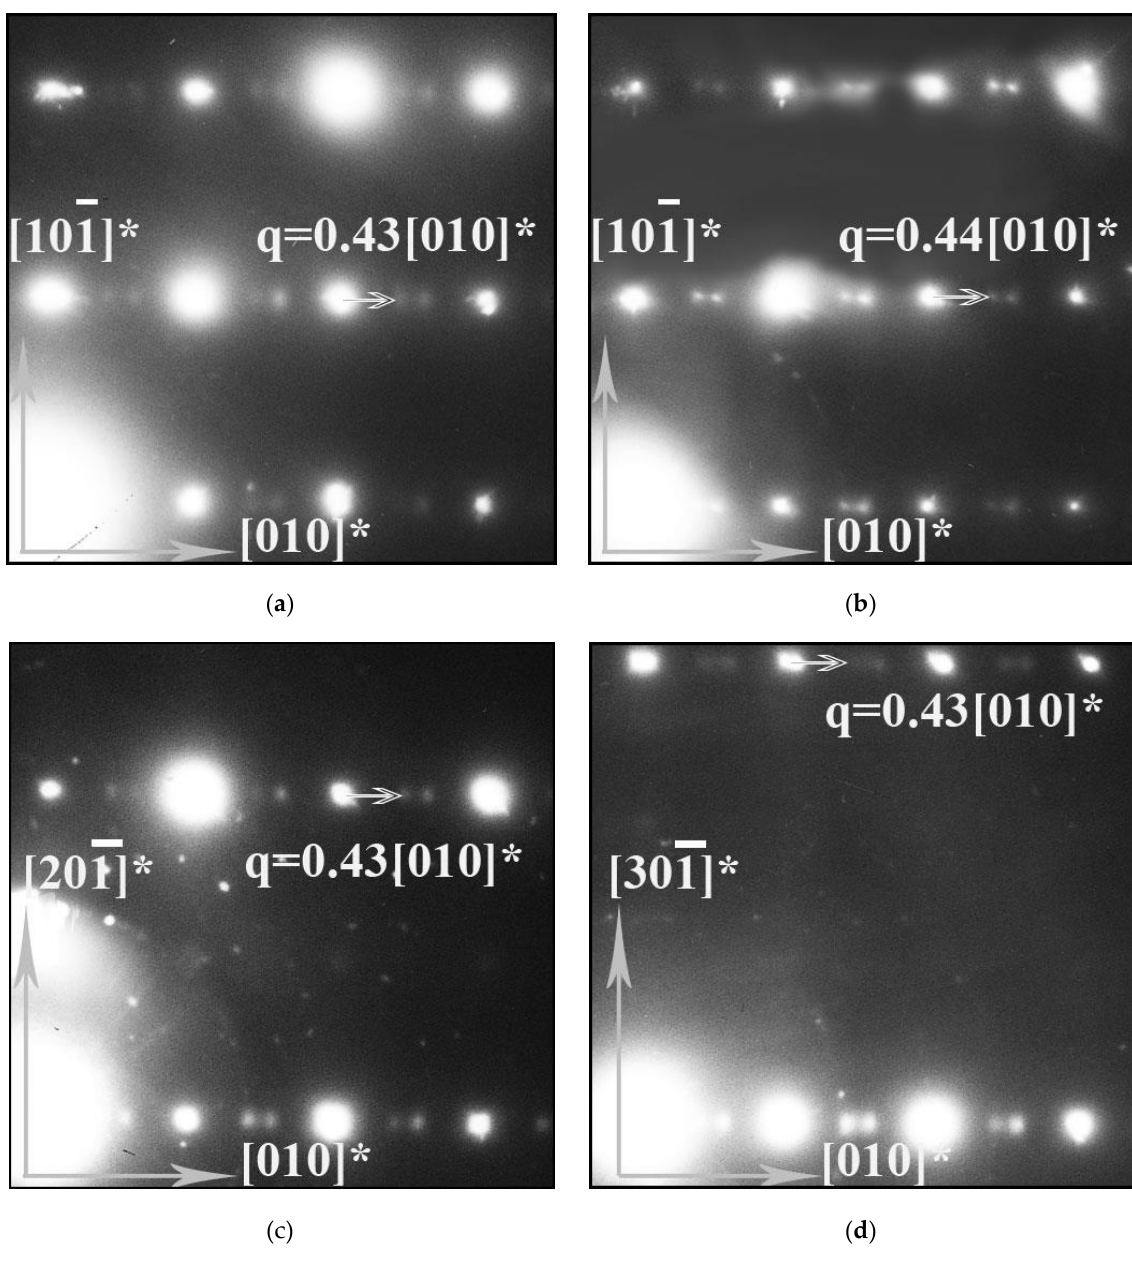
Figure 4. SAED patterns for the reduced PrBaFe 2 O 6− δ , zone axis: ( a , b ) — [101], ( c ) — [102], ( d ) — [103]. Positions of the diffuse reflections are shown by the incommensurate q vectors.